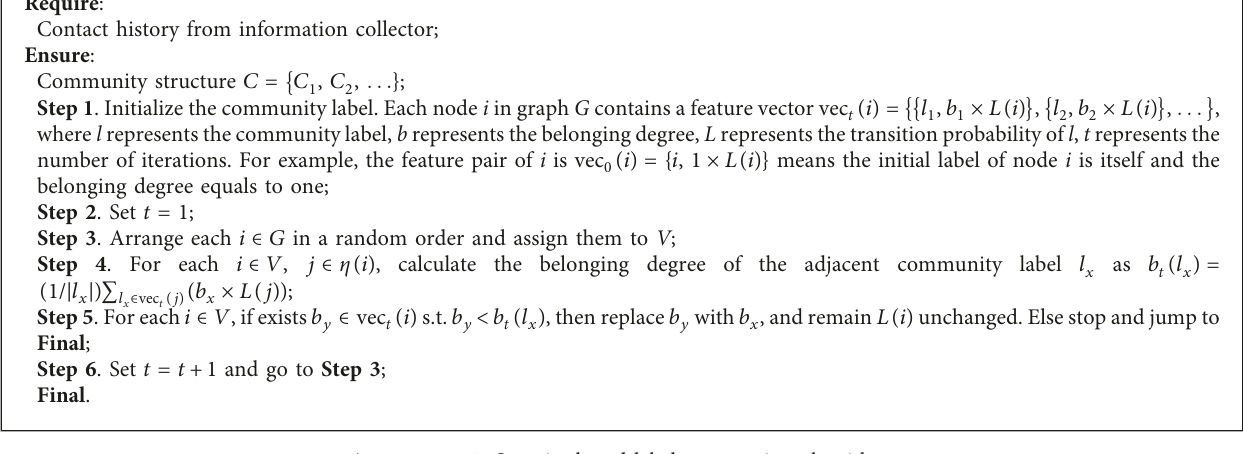
A LGORITHM 1: Security-based label propagation